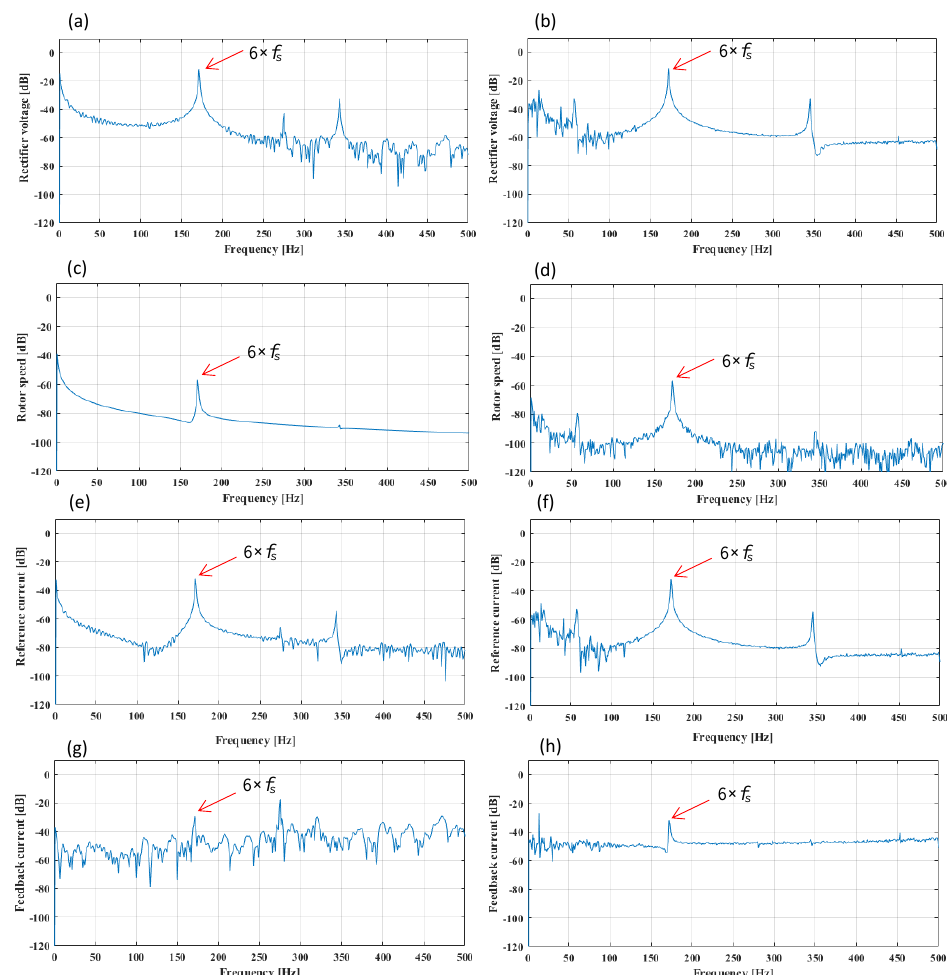
Figure 10. Healthy condition DoS results in frequency domain at the wind speed v w = 10 m/s. ( a ) Three–phase line voltages of PMSG. ( c ) Three–phase stator currents of PMSG. ( e ) Output voltage of the three–phase diode rectifier. ( g ) Rotor speed of PMSG. ( i ) Feedback and reference currents at the input of boost converter. Healthy condition DRTS results in frequency domain at the wind speed v w = 10 m/s. ( b ) Three–phase line voltages of PMSG. ( d ) Three–phase stator currents of PMSG. ( f ) Output voltage of the three–phase diode rectifier. ( h ) Rotor speed of PMSG. ( j ) Feedback and reference currents at the input of boost